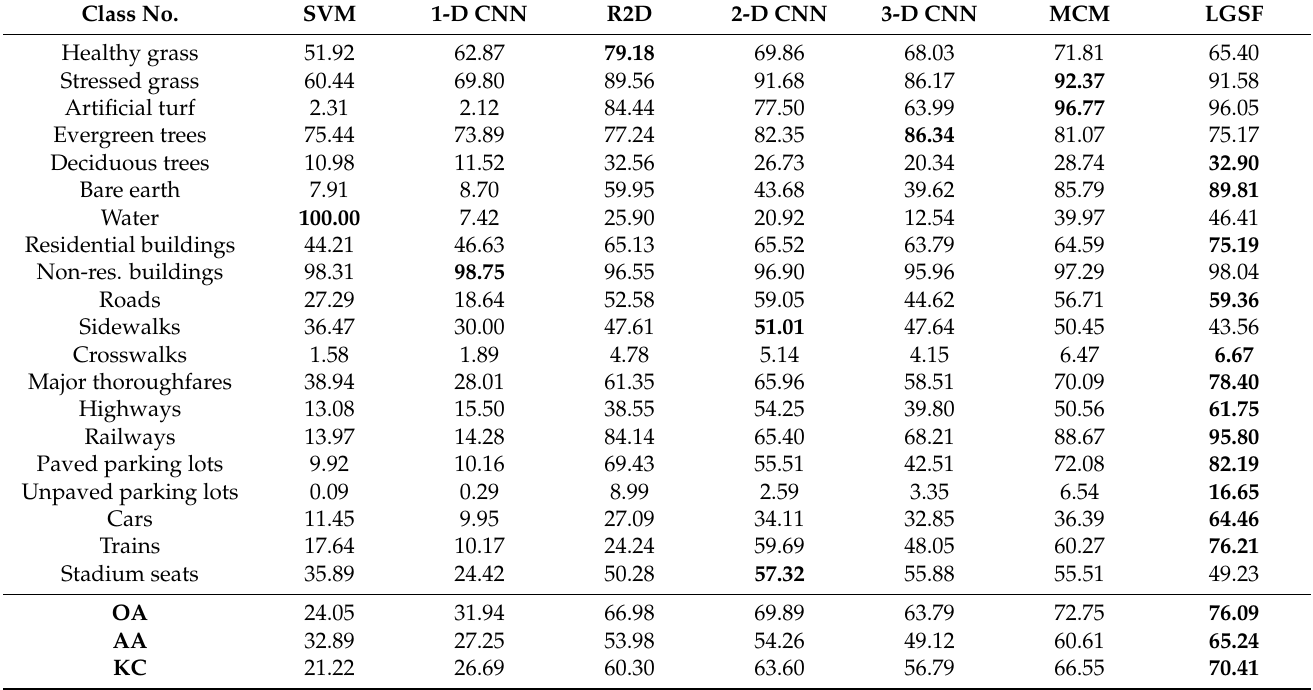
Table 6. Classification results of different methods on the Houston 2018 dataset. (shown in %).